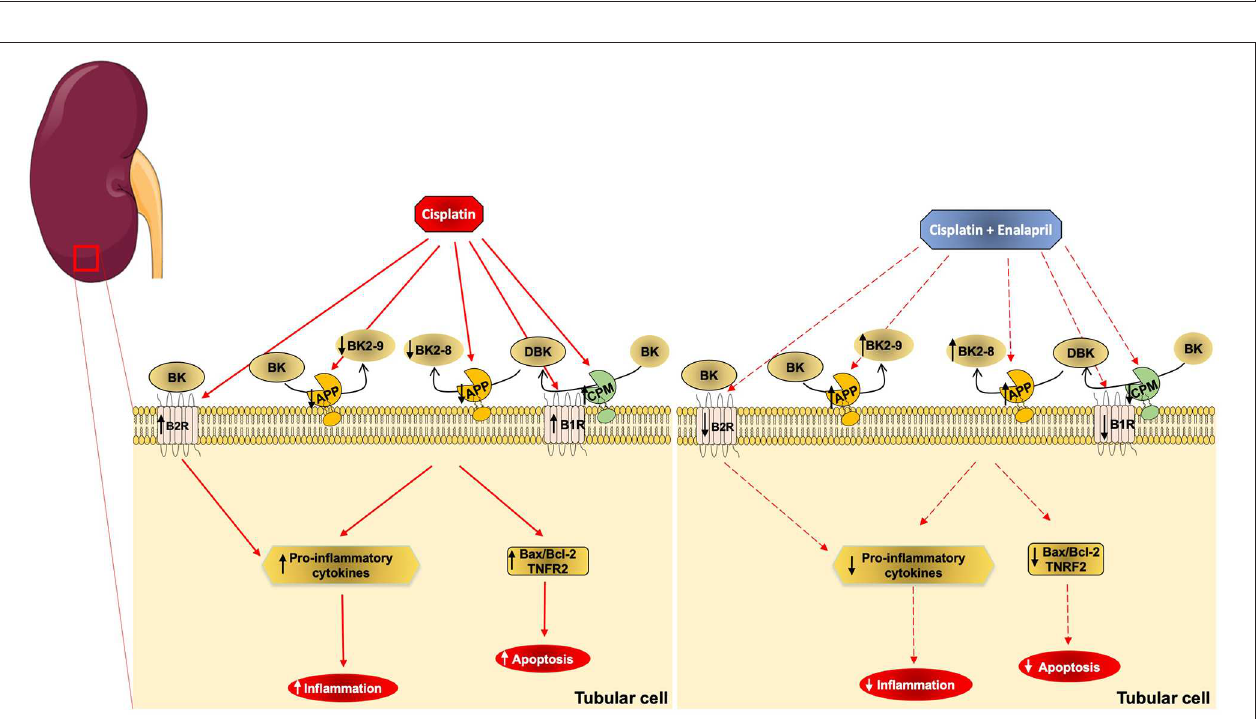
FIGURE 7 | Carboxypeptidase M mRNA expression in renal tissue and mouse epithelial tubular cells. The panels show CPM mRNA expression (A) in mice 24h after treatment with cisplatin or cisplatin plus enalapril and CPM mRNA expression (B) in mouse tubular cells after treatment with cisplatin or enalaprilat plus cisplatin. Data presented as Mean ± SEM; ** p < 0.01, *** p < 0.001.